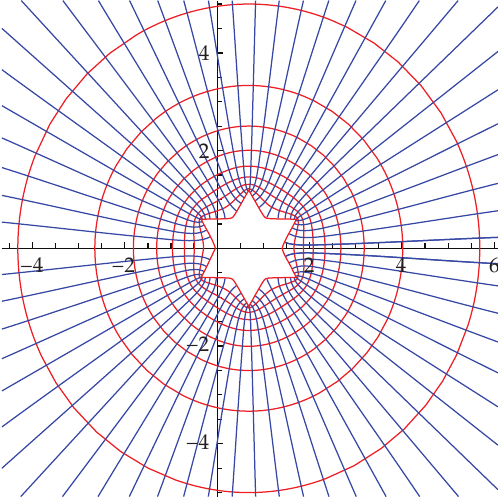
Figure 14: Exterior of the Koch snowflake, Step